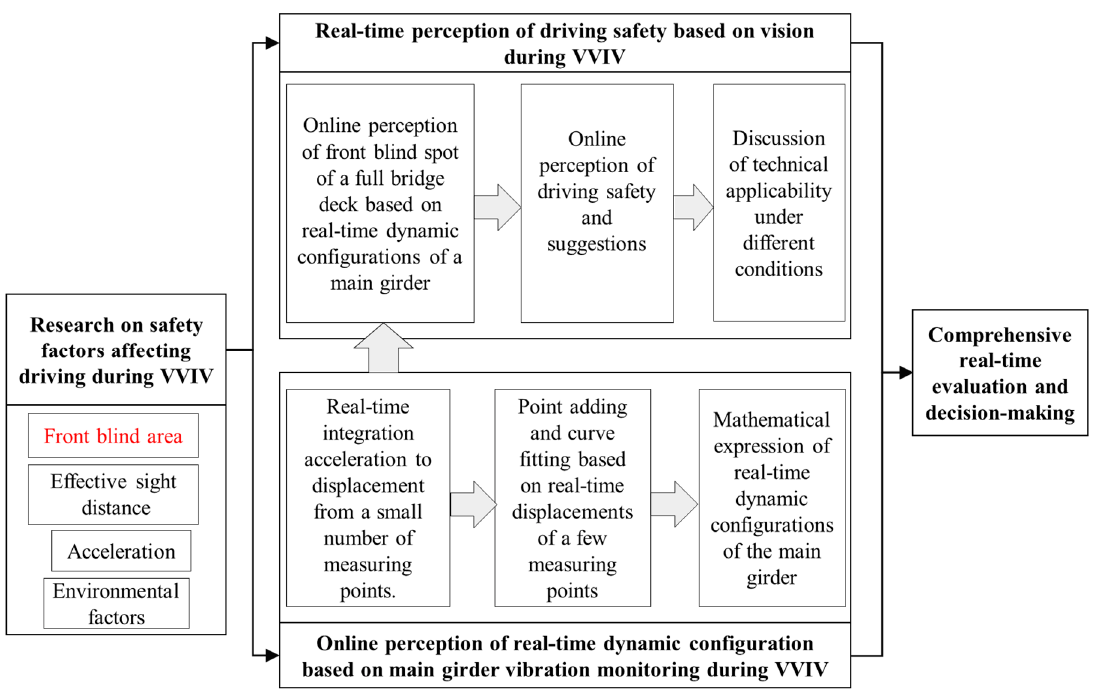
Figure 4. Technical route of online perception of front blind area based on real-time dynamic con- figurations of main beams.